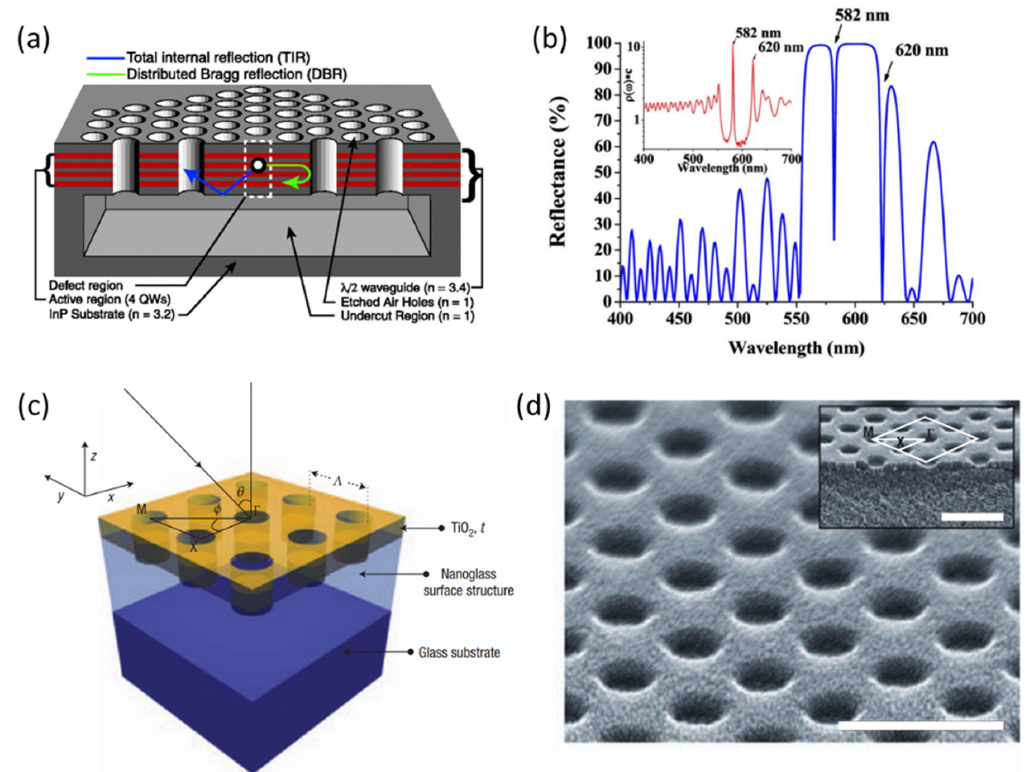
Figure 5. ( a ) Cross section through the middle of the PC microcavity. A defect is formed in the 2D PC by removing a single hole. The combination of Bragg reflection from the 2D PC and TIR from the low ‐ index cladding (air) results in a three ‐ dimensional confined optical mode, adapted with permission from [154]. ( b ) The calculated reflectance spectrum of the defect ‐ mode 1DPC, glass ‐ (PMMA ‐ TiO2)15 ‐ (DCM/PMMA) ‐ (TiO2 ‐ PMMA)15 ‐ air, at normal incidence of light by transfer matrix method. Arrows indicate the localized defect modes. The inset shows the calculated density of states of photons, ρ ( ω ) ≡ dk/d ω , of the defect ‐ mode 1D PC, in which the y ‐ axis shows normalized ρ ( ω ) with respect to the value in vacuum ρ ( ω )vac = 1/c, adapted with permission from [156]. ( c ) The layout of the two ‐ dimensional PC device. ( d ) Scanning electron microscope images of a sample fab ‐ ricated by the nanoreplica molding approach. Γ , X, and M are points of high symmetry. Λ is the period of the square lattice, t is the thickness of the high ‐ index layer, and θ is the angle the incident beam makes with the vertical. Scale bars = 500 nm, adapted with permission from [37].